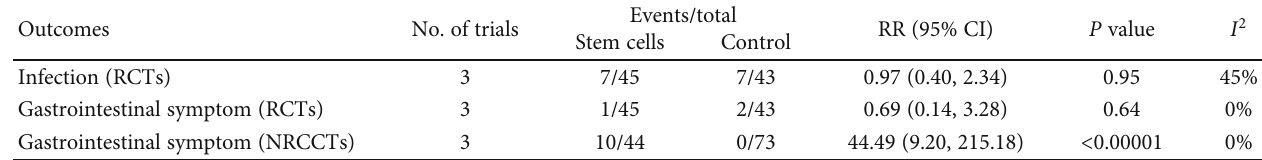
Table 4: Incidence of adverse events in the experimental and control group (RCTs and